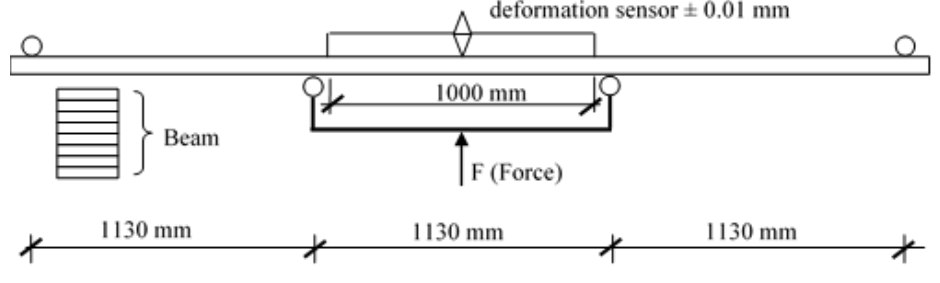
Figure 3. A loading scheme for glued beams.